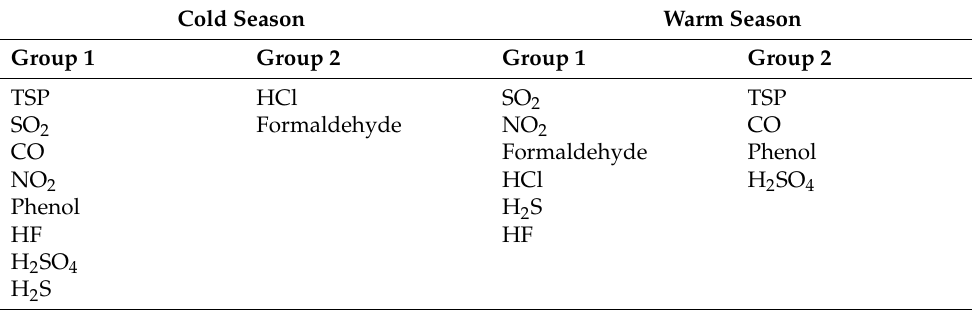
Table 6. Grouped PCs for cold and warm